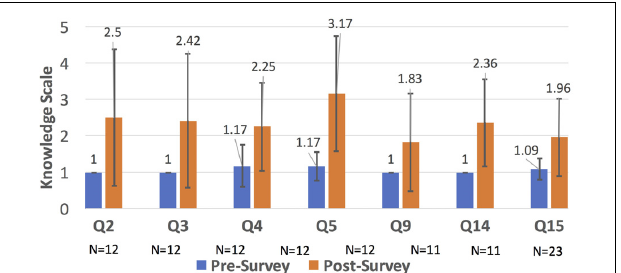
FIGURE 3 | Bar chart comparison of the knowledge scale for different bioinformatic topics (that were statistically significant). In around 7 areas (many related to microbiome analysis), there was improved knowledge. Other areas, see Supplementary Material , were not noticeably improved due to removal because of curricular changes, lack of enough responses, or no significance between the pre- and post-